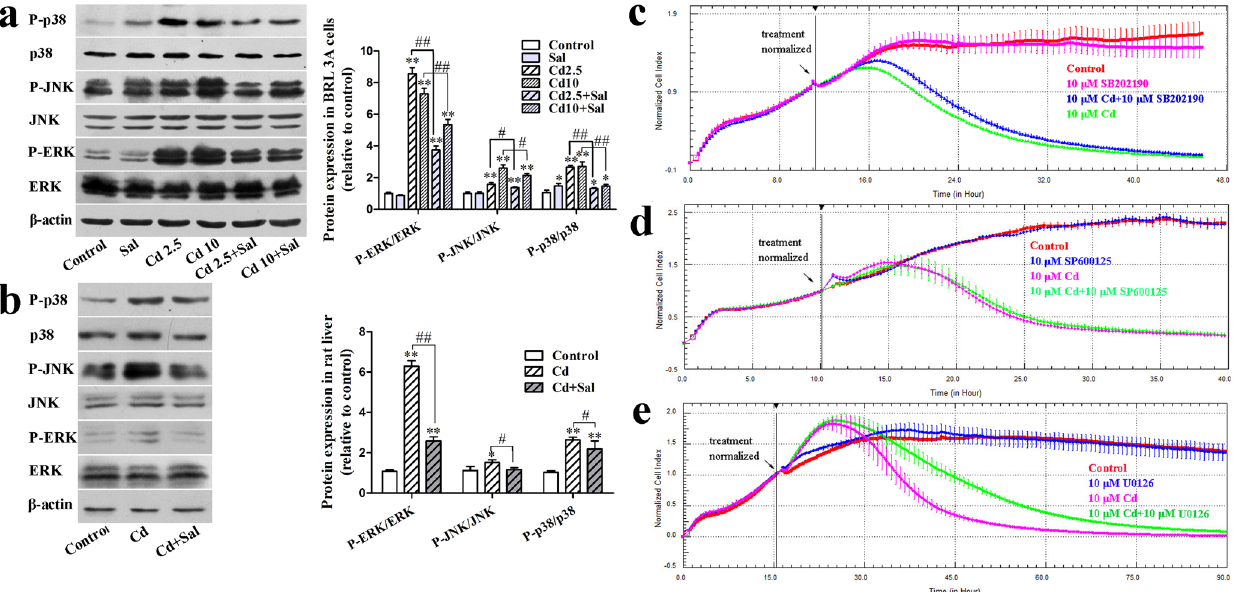
Fig 4. Cd activates the MAPK pathway in BRL 3A cells and rat liver tissue. Effect of Sal on Cd-induced phosphorylation of MAPKs in BRL 3A cells ( a ) and rat liver tissue ( b ). Values shown are the means ± S.D. of at least three independent experiments. Each value is expressed as the phospho/total MAPK percentage of phosphorylation. ** p < 0.01 and * p < 0.05 compared with control group; # p < 0.05 and ## p < 0.01 compared with the indicated group. c , d , e : Effects of U0126, SP600125 and SB202190 on Cd-induced cytotoxicity.